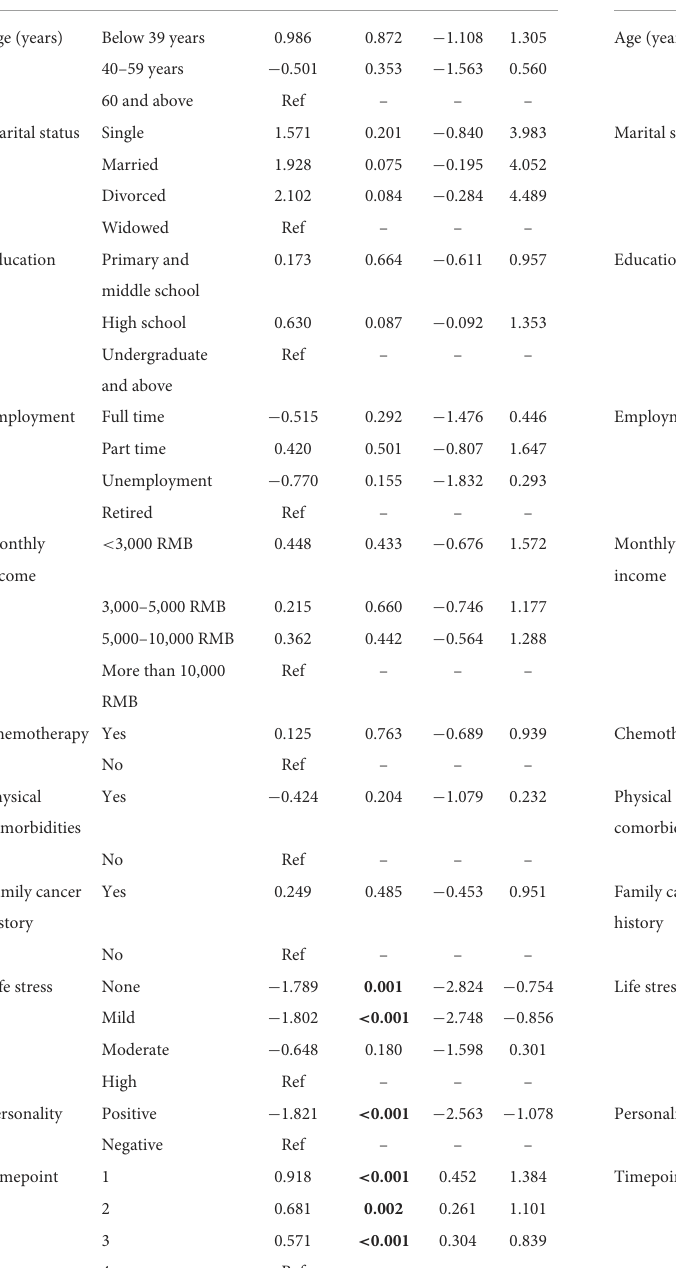
TABLE 3 Associations between baseline variables on the changes of depression in linear mixed models.